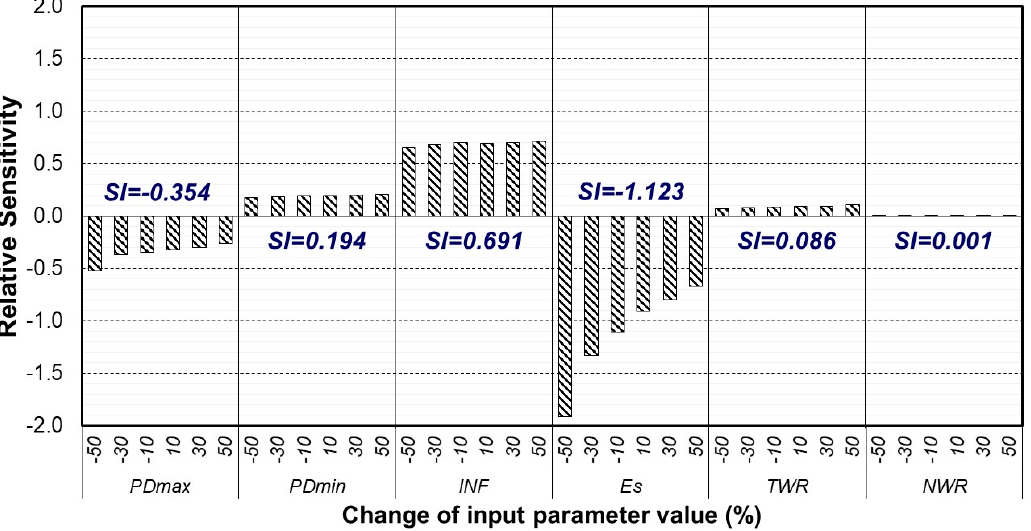
Figure 2. Parameter sensitivity in estimating agricultural water supply.